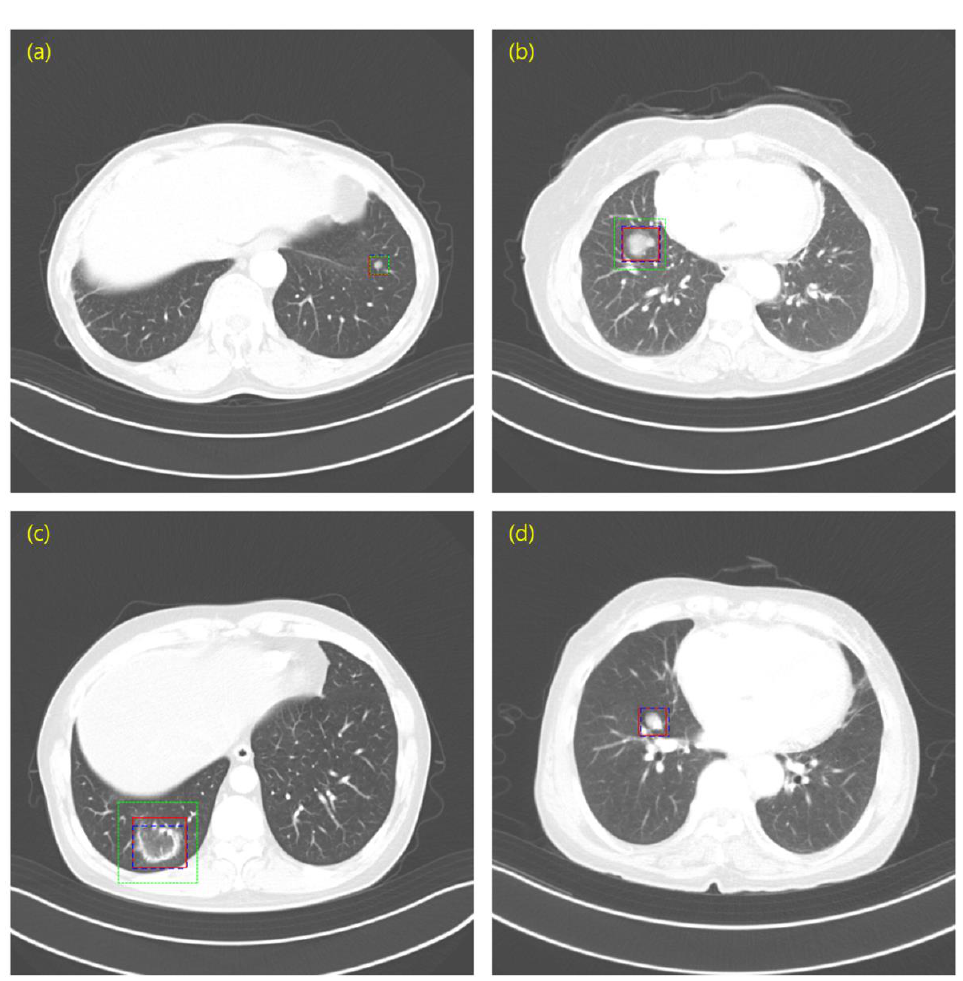
Figure 6. Image sample overlapping the prediction results of the LUNA16 and private data trained models and the ground truth. ( a ) Case where the predictions of the model trained on LUNA16 and the model trained on private data is very similar to the ground truth; ( b , c ) Case where the predicted box of the model trained on LUNA16 is significantly larger than the size of the ground truth; ( d ) Case in which the LUNA16 trained model did not predict lung nodules. Red (Solid line) = Ground Truth; Blue (Dashed line) = Private data; Green (Dotted line) = LUNA16. Blue (Dashed line) = Private data; Green (Dotted line) =